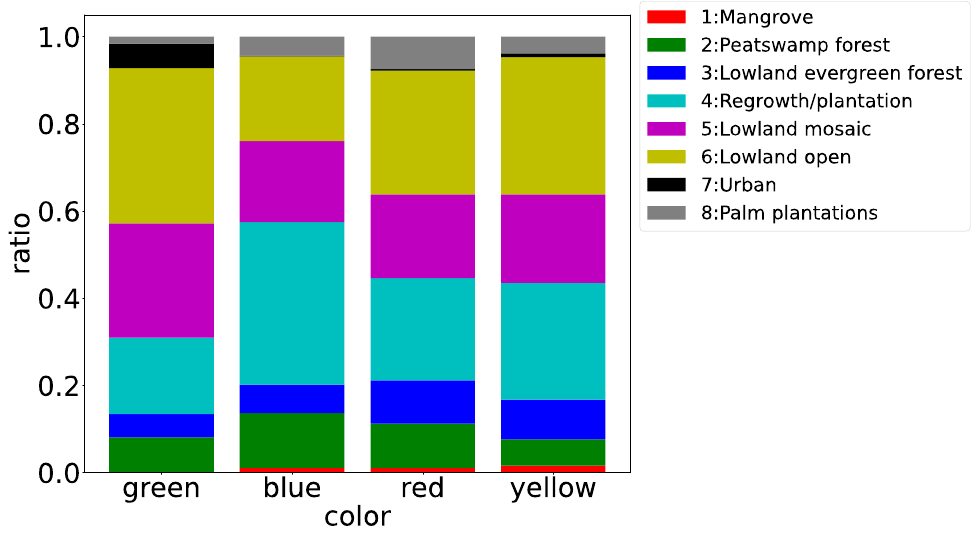
Figure 18. Ratio of eight land cover classes for each color.